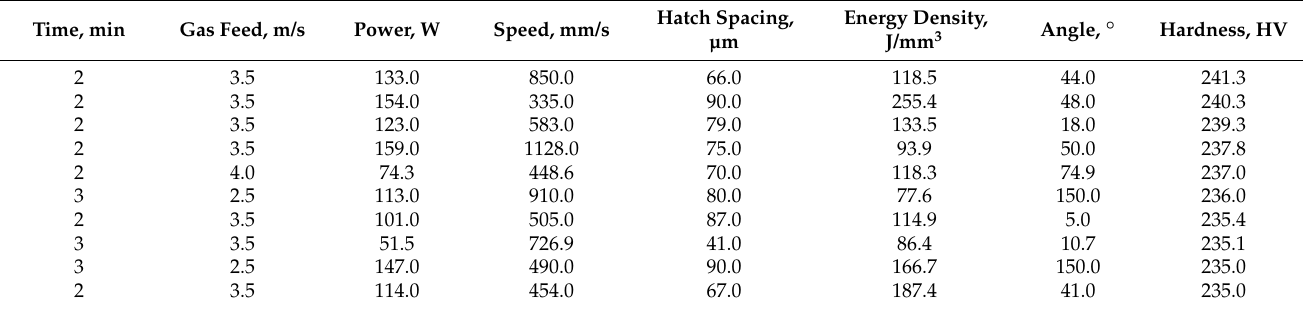
Table 2. Empirically obtained process parameter configurations sorted by highest